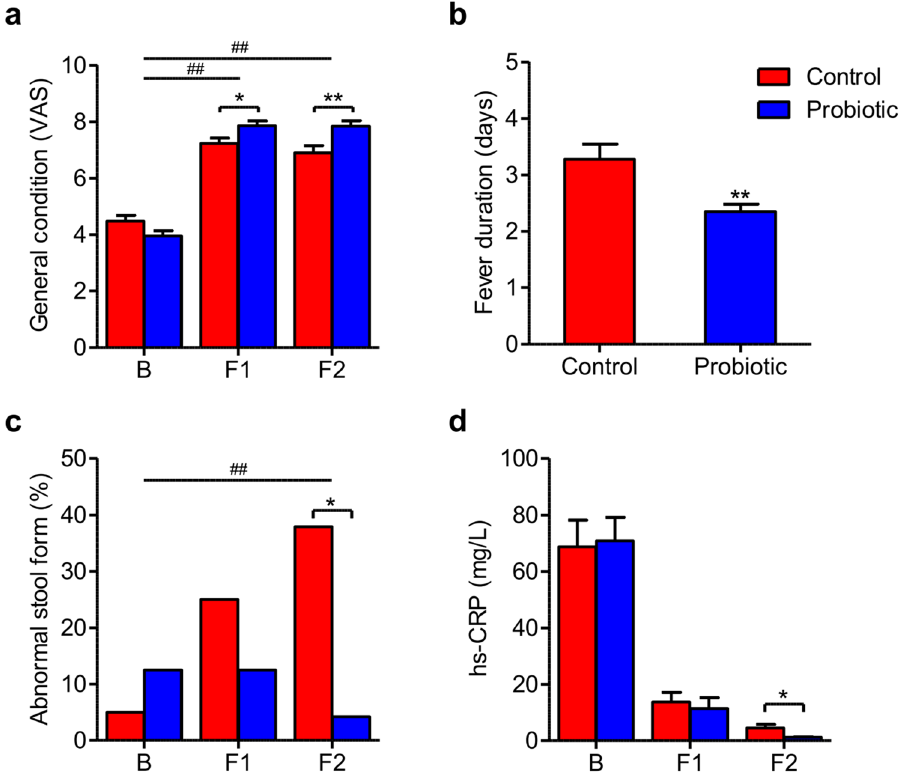
Figure 2. Comparison of clinical manifestations depending on the administration of the probiotic. Values are mean ± SEM. * P < 0.05, ** P < 0.01 versus control, and ## P < 0.01 versus control comparing Δ-values. B, baseline; F1, 1 week after treatment; F2, 2 weeks after